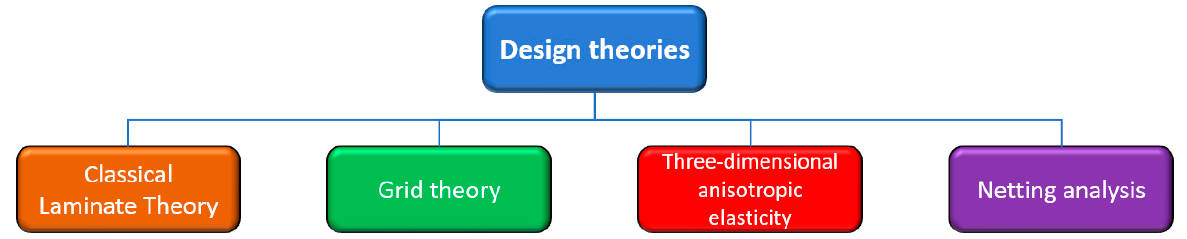
Figure 7. Design theories of hydrogen storage tanks.